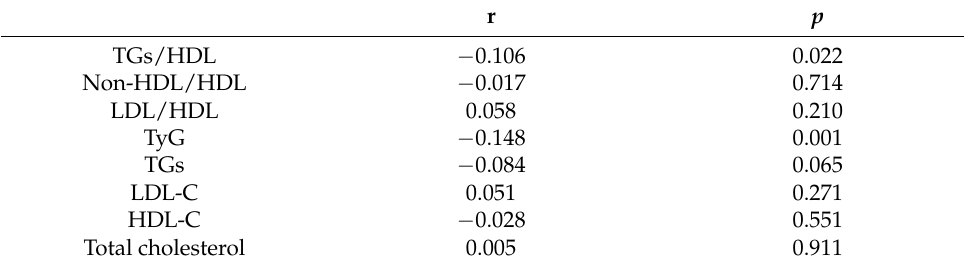
Table 3. Pearson correlations between the lipid ratio and eGFR.